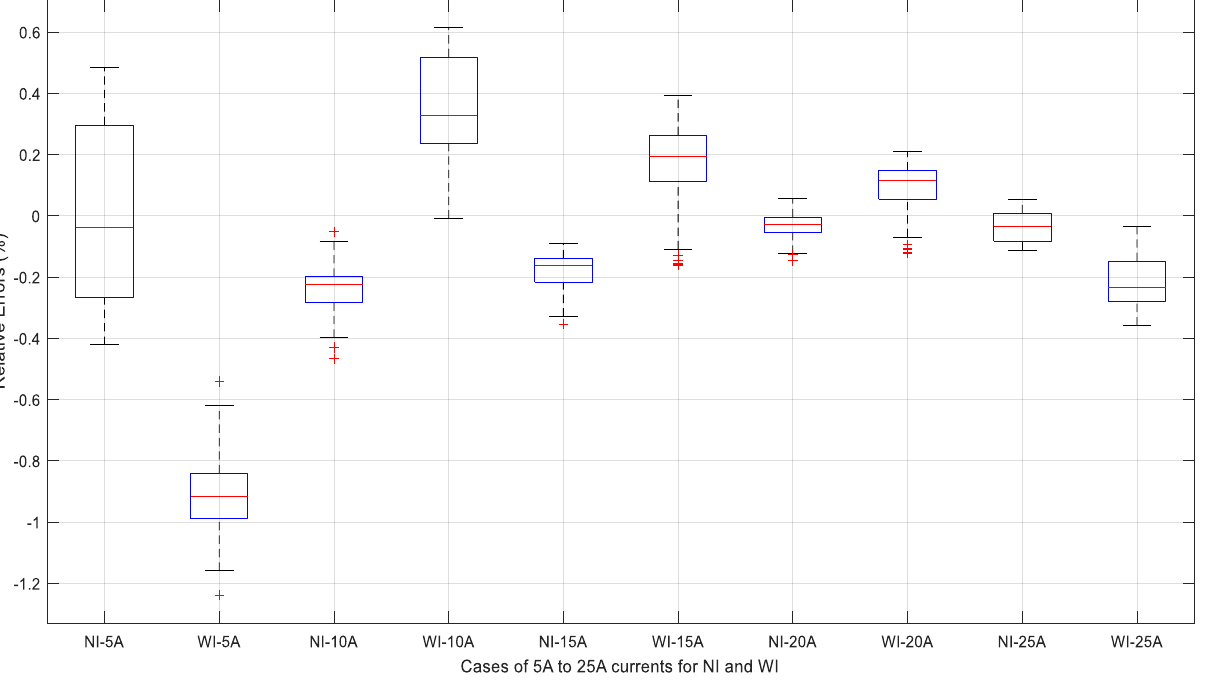
Figure 16. Output of all sensors for 25 A, 7 mm, 60 Hz: No-Insulation case.